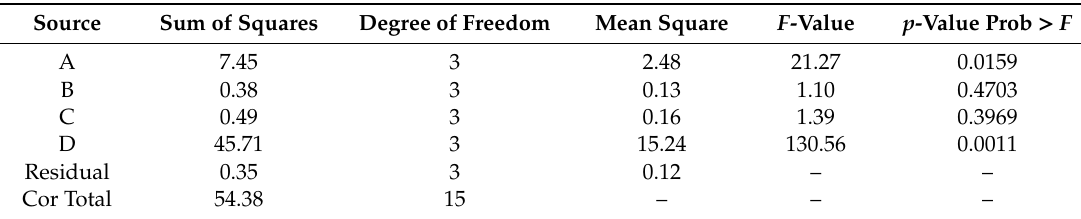
Table 4. ANOVA on S / N of flatness ratio.